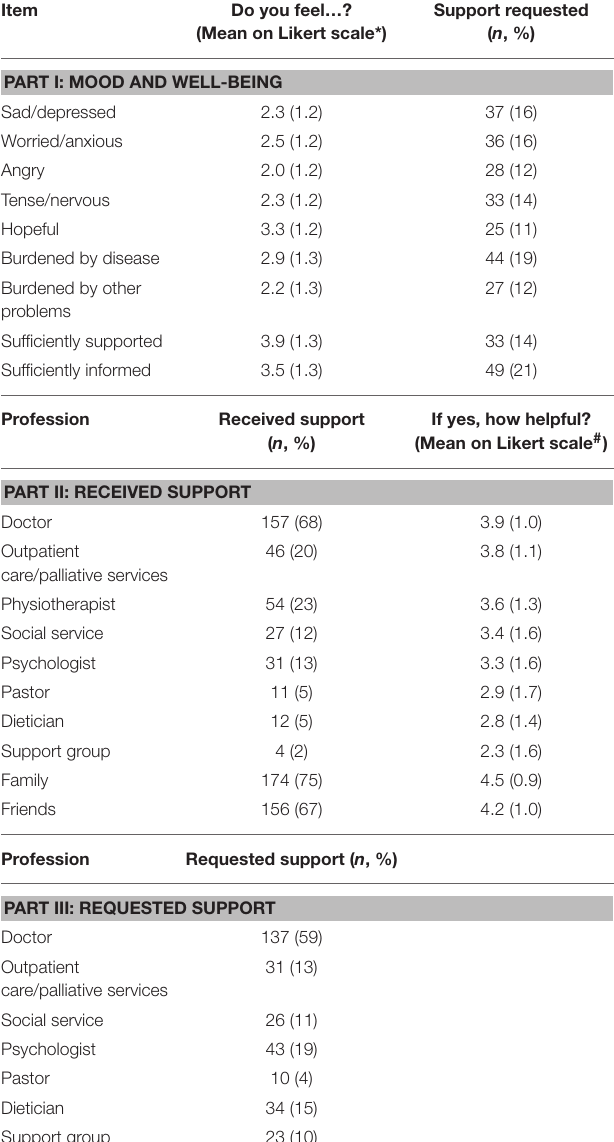
TABLE 2 | Results of assessments in 232 patients using the